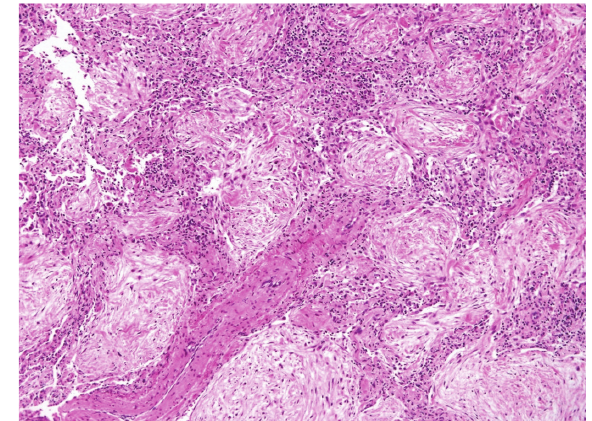
Figure 1: A chest computed tomography showed bilateral multiple nodules predominantly subpleural parenchyma. Figure 2: Microscopic examination revealed inflamed granulation tissue occupying terminal bronchioles and alveolar space (hematox- ylin-eosin; original magnification, ×